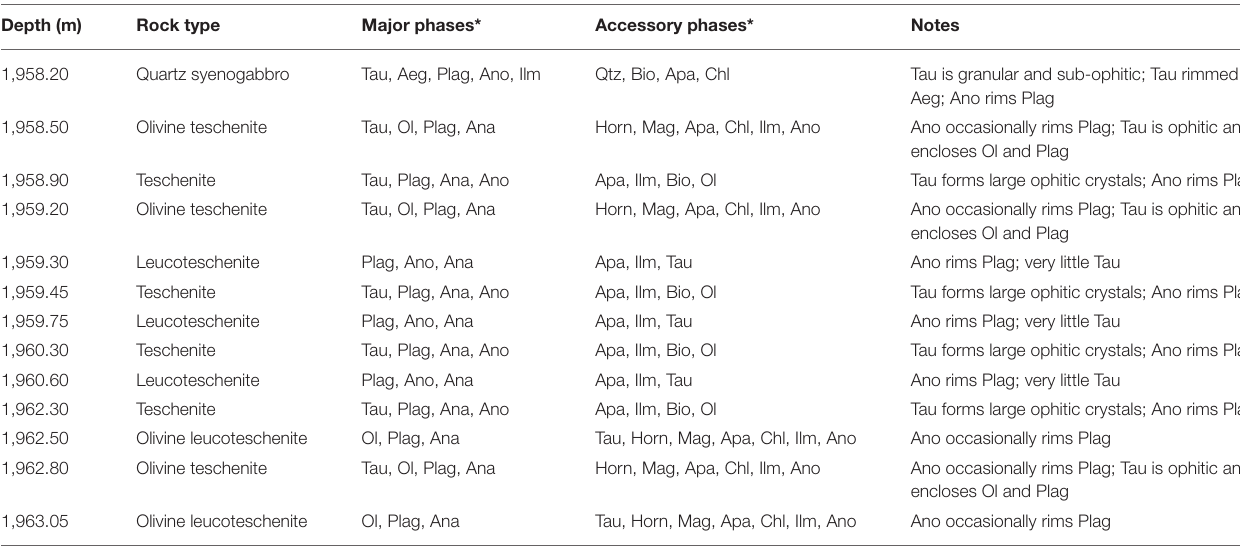
TABLE 1 | Resolution-1 continuous core